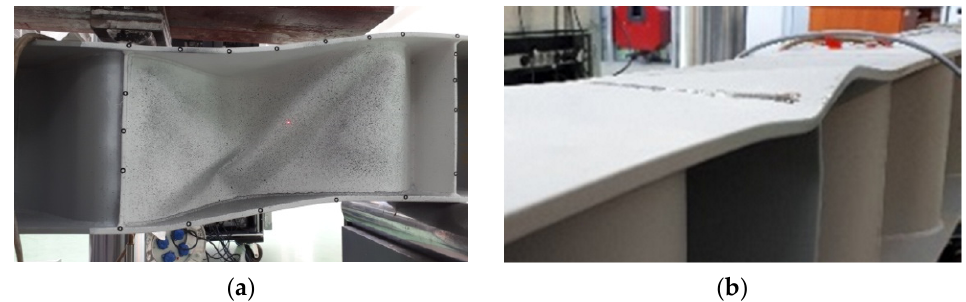
Figure 13. Forms of failure of BS 381 beams: ( a ) 3 mm-thick web and ( b ) 5 mm-thick web.